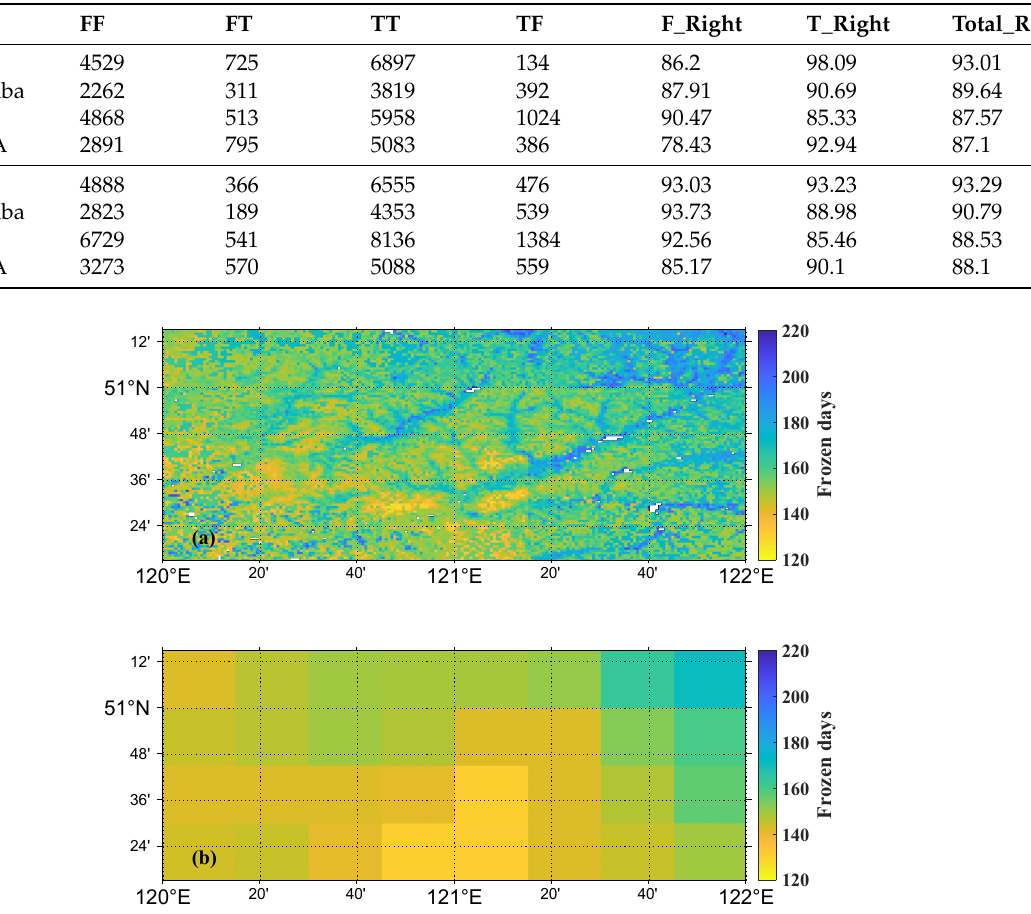
Figure 22. Comparisons of thawed ( a ), frozen ( b ), and total ( c ) accuracies between F/T AMSR2 and F/T new at the site level. Table 8. Classification accuracy (%) statistics for F/T AMSR2 and F/T new .